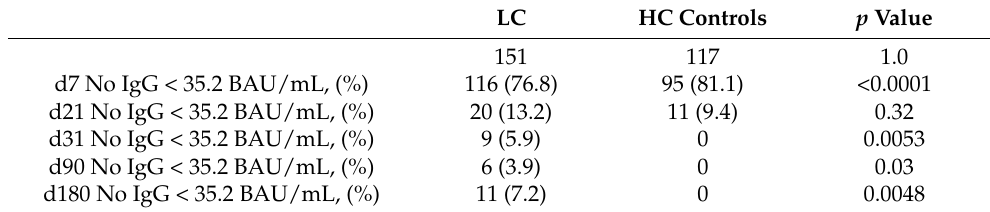
Table 2. Numbers and percentage of cirrhotic patients with antibody titers higher than the as- say threshold.